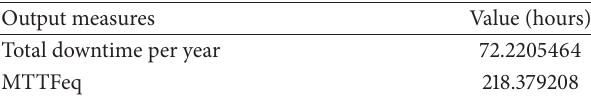
Table 6: VMs subsystem